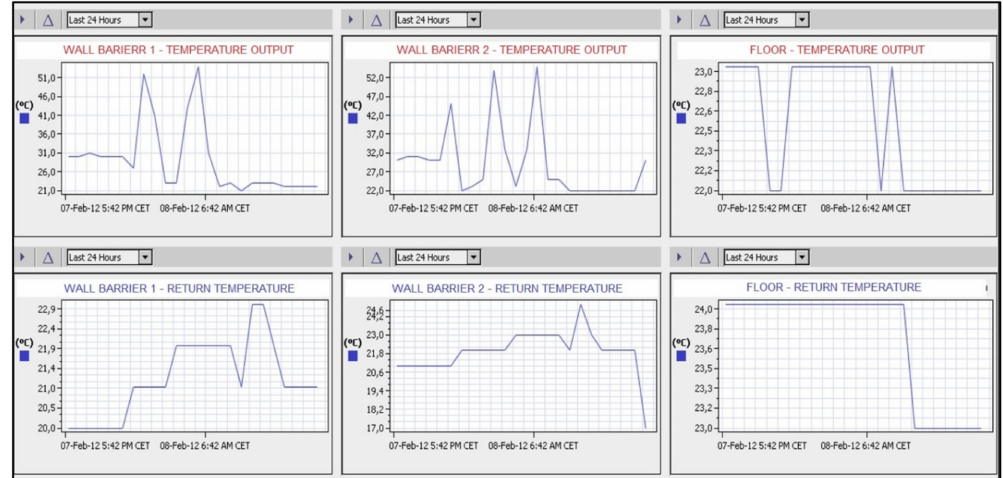
Figure 29. Display the working substance’s temperature in the supply (red) and return (blue) pipes from ATP1, ATP2, and underfloor heating for the last 24 h